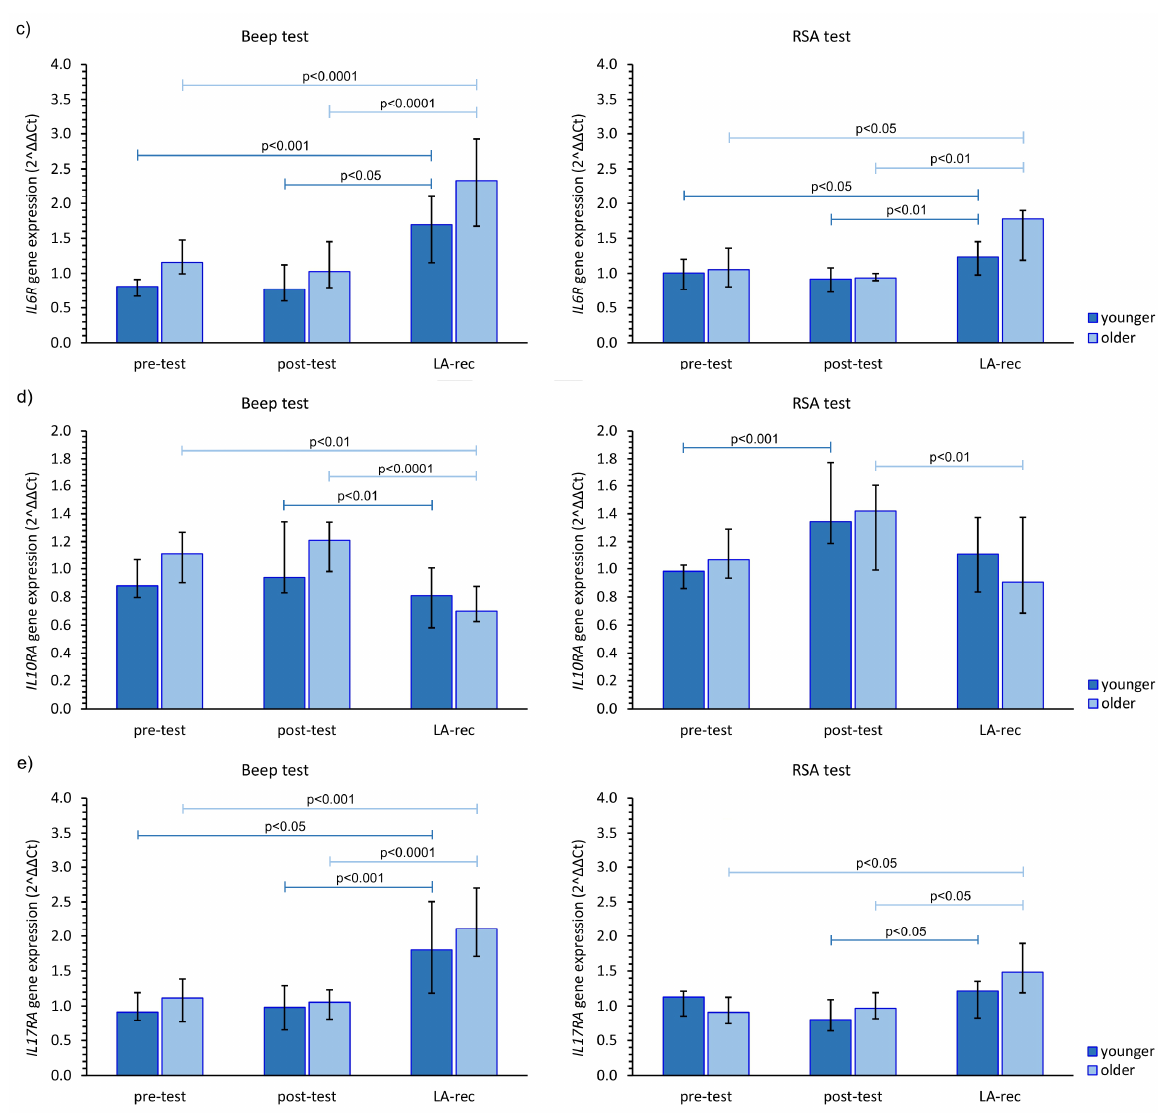
Figure 4. The impact of aerobic (Beep test) and anaerobic (RSA test) effort on the relative expression of studied genes encoding ( a ) IL2RA , ( b ) IL4R , ( c ) IL6R , ( d ) IL10RA , ( e ) IL17RA . The figures present median (interquartile range) values. Significance levels of differences observed between analyzed time points (pre-test vs. post-test vs. LA-rec) were assessed using Friedman’s analysis of variance for repeated measures followed by post hoc Dunn’s test with Bonferroni